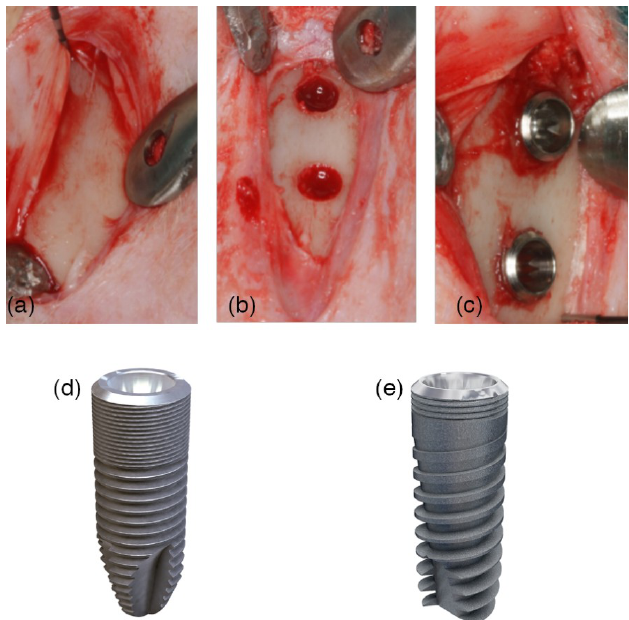
Figure 1. A surgical image. ( a ) An incision in the skin was performed at the medial section of the tibia. The surgical flaps were raised, showing off the proximal area of the tibia. ( b ) Two implantation sites were prepared with the same drill protocol, at the metaphysis and the diaphysis areas. ( c ) Randomly, two implants with different macro-designs were installed and separated by a distance of 8 mm in between. ( d ) Ticare Inhex ® : The implant body had a little conicity and a large area of micro-threads at the coronal portion, and a higher number of triangular threads per unit length and with little thread depth compared to the Quattro ® model. Moreover, the implant featured a double self-tapping at the apical portion. ( e ) Ticare Inhex Quattro ® : The implant body had a marked conicity. Fewer micro-threads at the coronal portion and a lower number of macro-threads were present as compared to Ticare Inhex ® implants. The threads were squared in the middle part of the implant and became triangular and deeper at the apex, with aggressive self-tapping at the